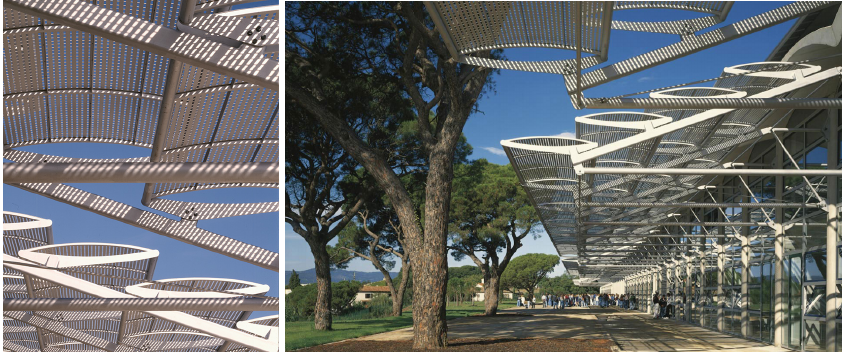
Figure 5. Lycée Albert Camus, Foster + Partners, Reprinted with Permission from © Dennis